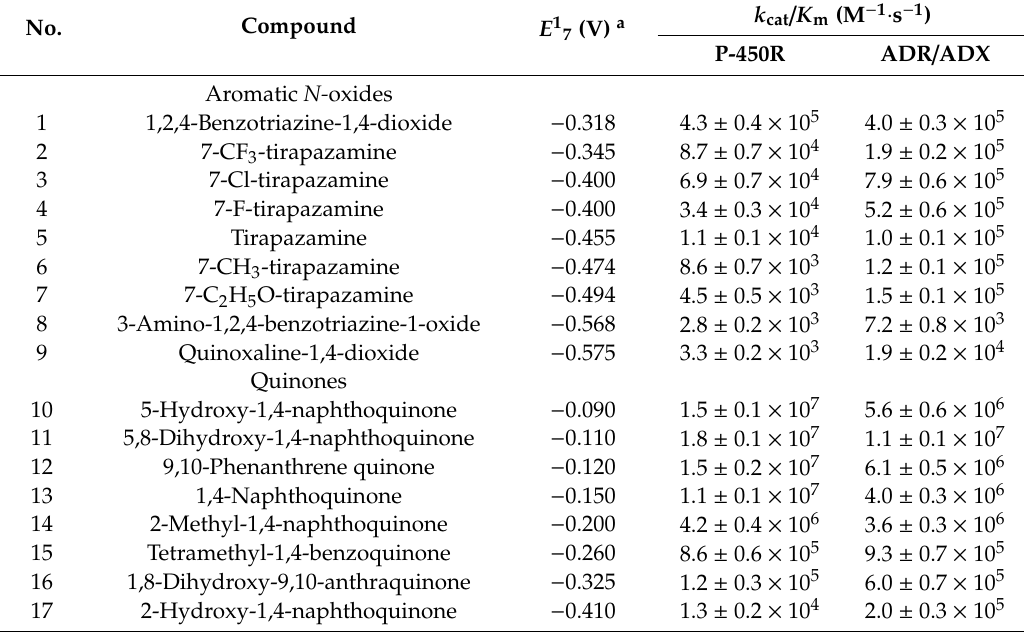
Table 1. The single-electron reduction midpoint potentials ( E 1 7 ) of compounds and the steady-state bimolecular rate constants ( k cat / K m ) of their reduction by P-450R and ADR / ADX. No.